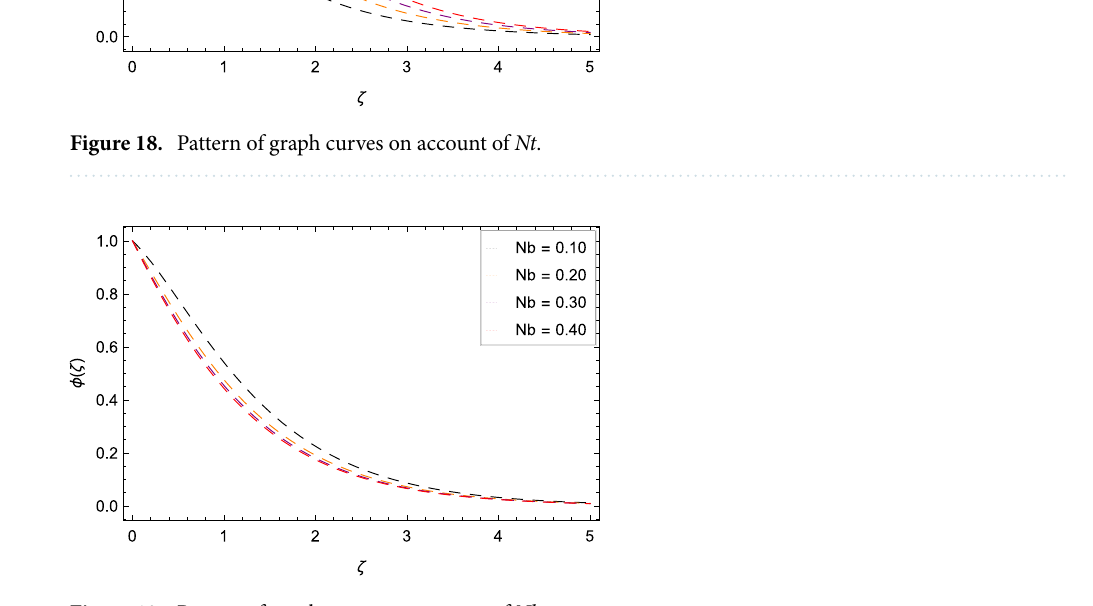
Figure 19. Pattern of graph curves on account of Nb